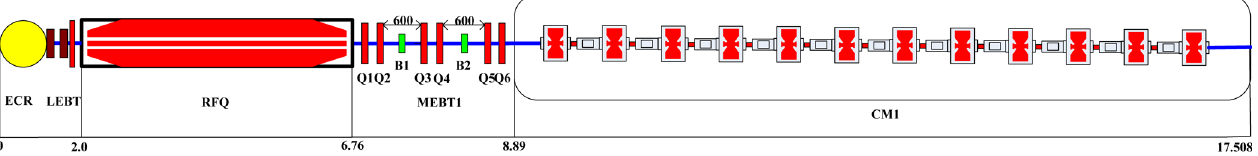
FIG. 4. Layout of the front end of the driver linac.